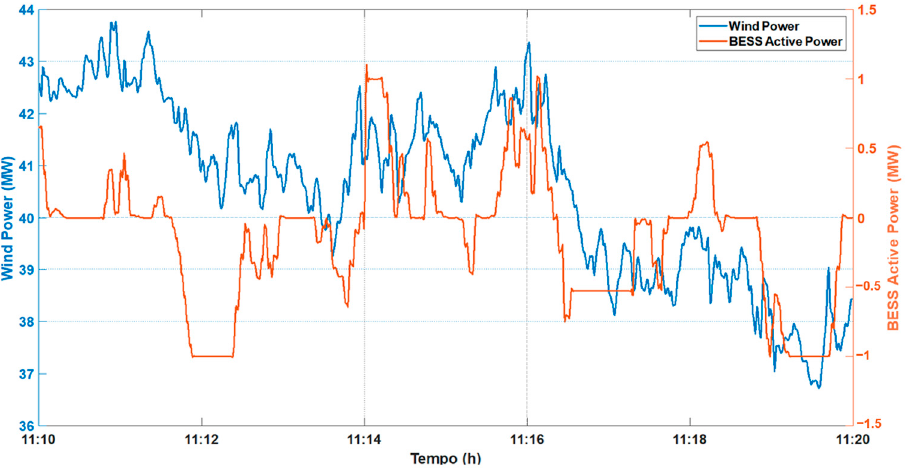
Figure 13. Power factor smoothing performed by BESS. Measurement performed on 13 August 2021.